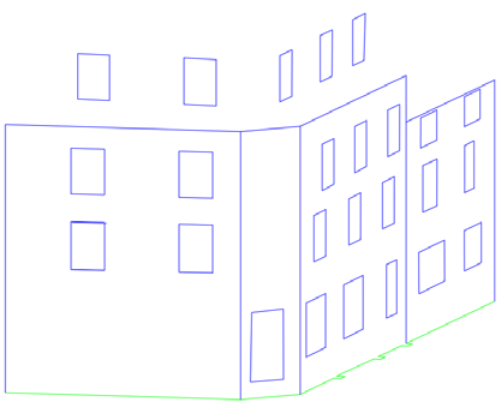
Figure 13: The building in a parcel 68134.902.236